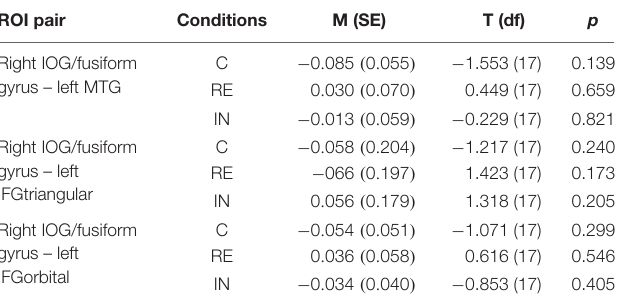
TABLE 3 | Changes in functional connectivity between R1 and